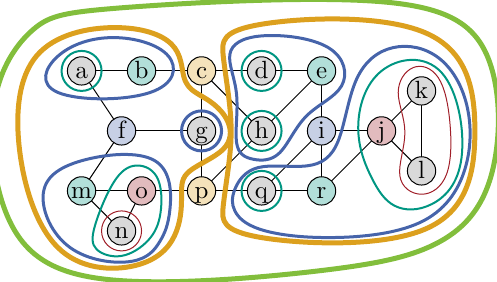
Figure 4. Node-based multilevel partition of the running example. The colors correspond to levels. The depicted multilevel partition can be obtained when partitioning the partitions of example Figure